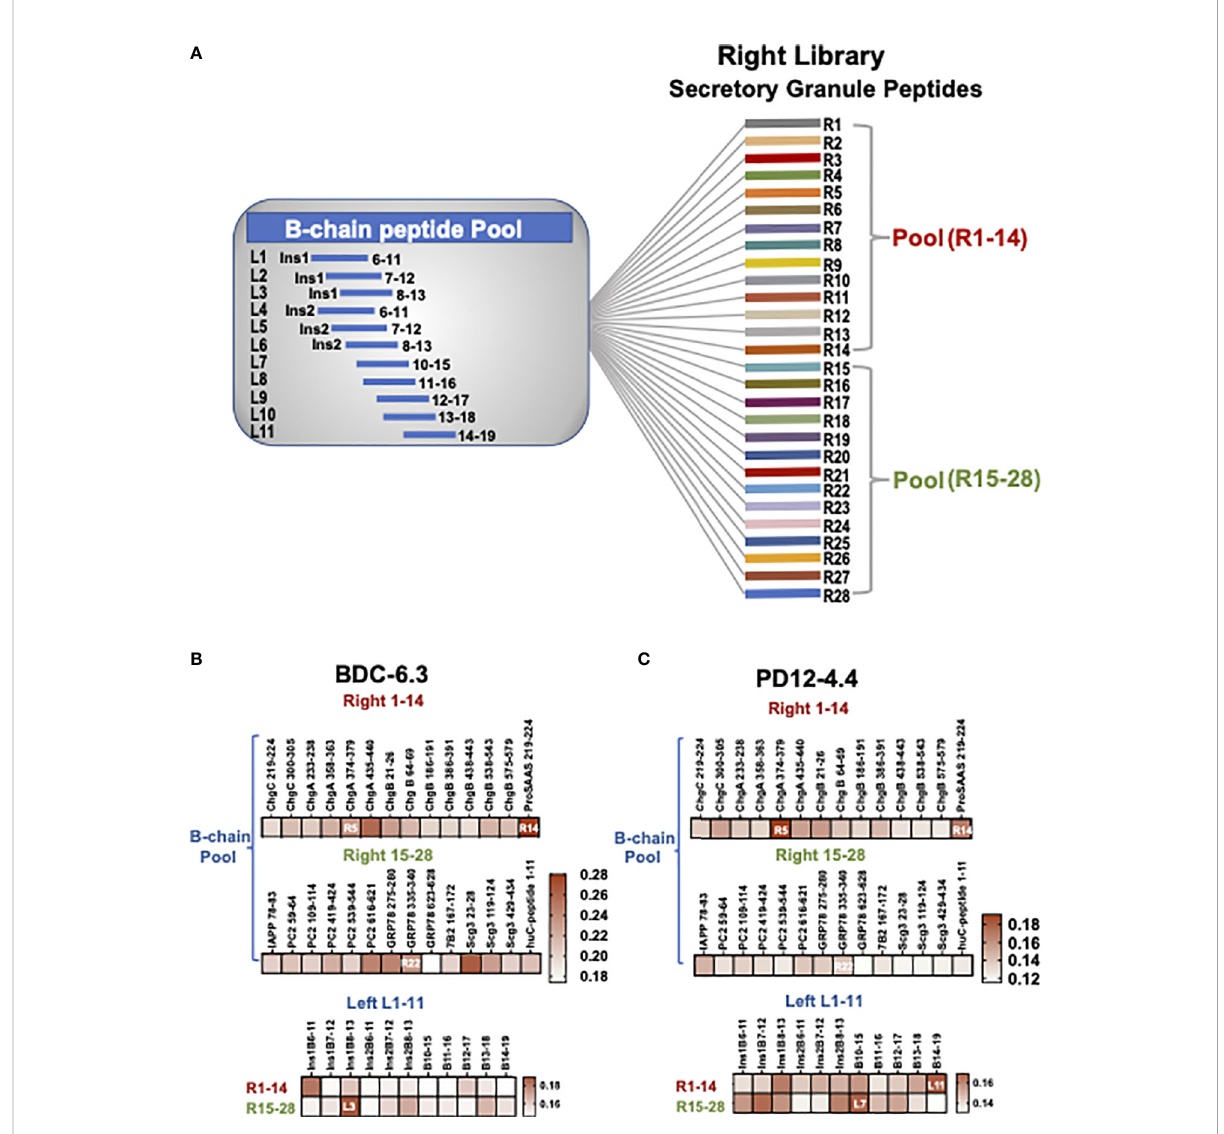
FIGURE 1 B-chain HIP crosslinking library scheme and IFN- g ELISAs for T cell clone BDC-6.3 and PD12-4.4. (A) In the Left Library, 11 individual B-chain peptides form peptide bonds with two pools of right secretory granule peptides (pools R1-14, R15-28). The Right Library is comprised of 28 individual right peptides that form peptide bonds with the pool of 11 B-chain left peptides. (B, C) Heat maps for IFN- g ELISA screening of T cell clones BDC-6.3 and PD12-4.4 with B chain Right and Left HIP libraries. Data is shown as absorption @ 415 nm minus background for a single screen for each T cell